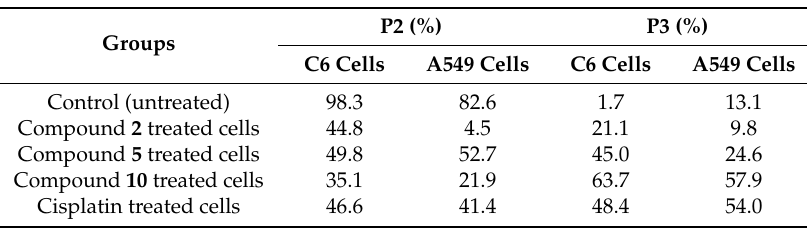
Table 3. The effects of the compounds on mitochondrial membrane potential of A549 and C6 cells for 24 h.